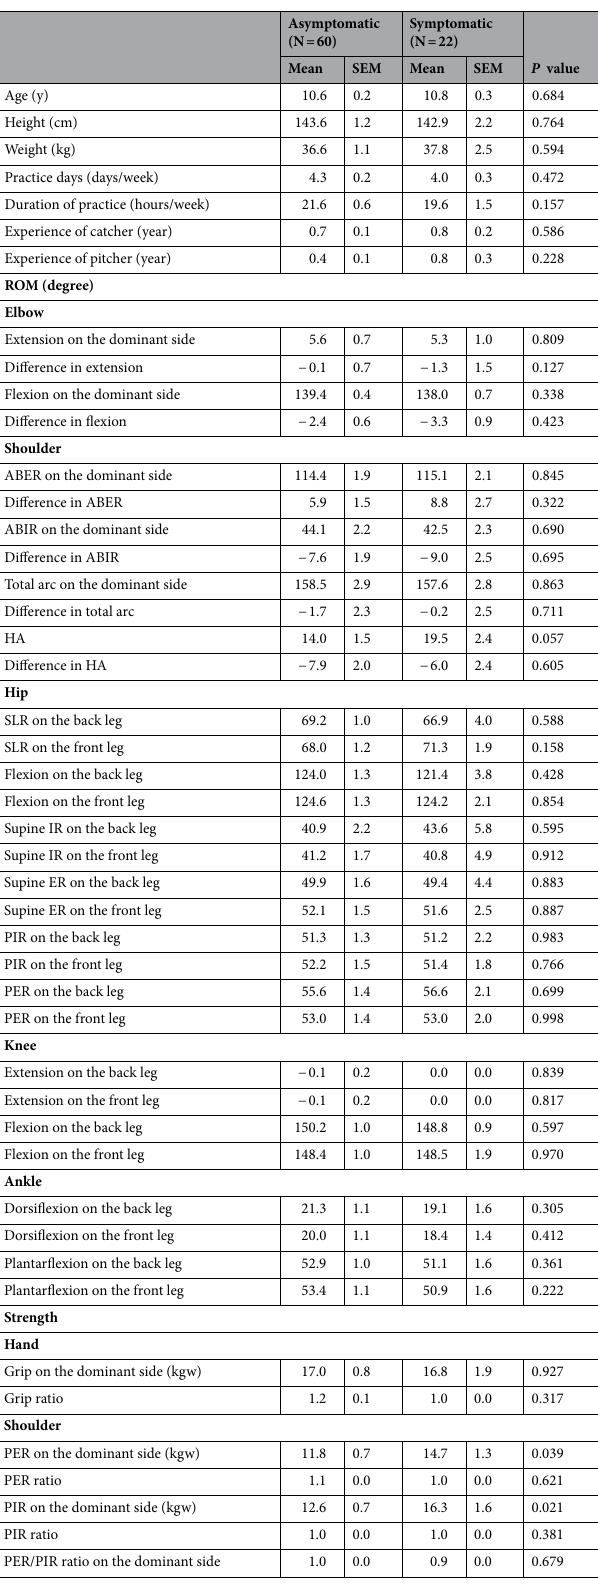
Table 1. Demographic data (continuous data). * P < 0.05. SEM: standard error of the mean. ABER, 90° abduction and external rotation; ABIR, 90° abduction and internal rotation; Total arc, ABER + ABIR; HA, horizontal adduction; ROM, range of motion; ROM difference, ROM of the dominant elbow minus ROM of the non-dominant elbow; SLR, straight-leg raising angle; ER, external rotation; IR, internal rotation; PER, prone external rotation; PIR, prone internal rotation; Strength ratio,